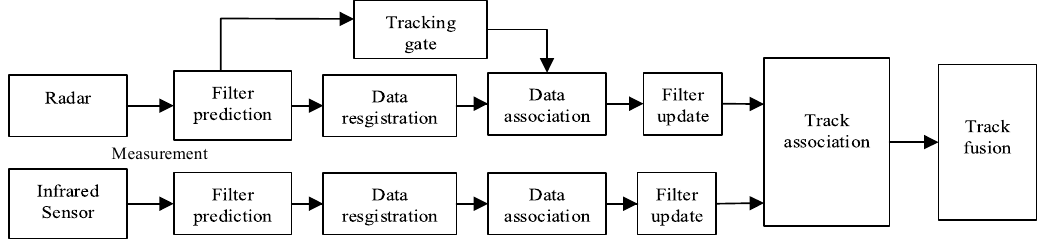
Figure 3. Distributed fusion model for multi-target tracking.